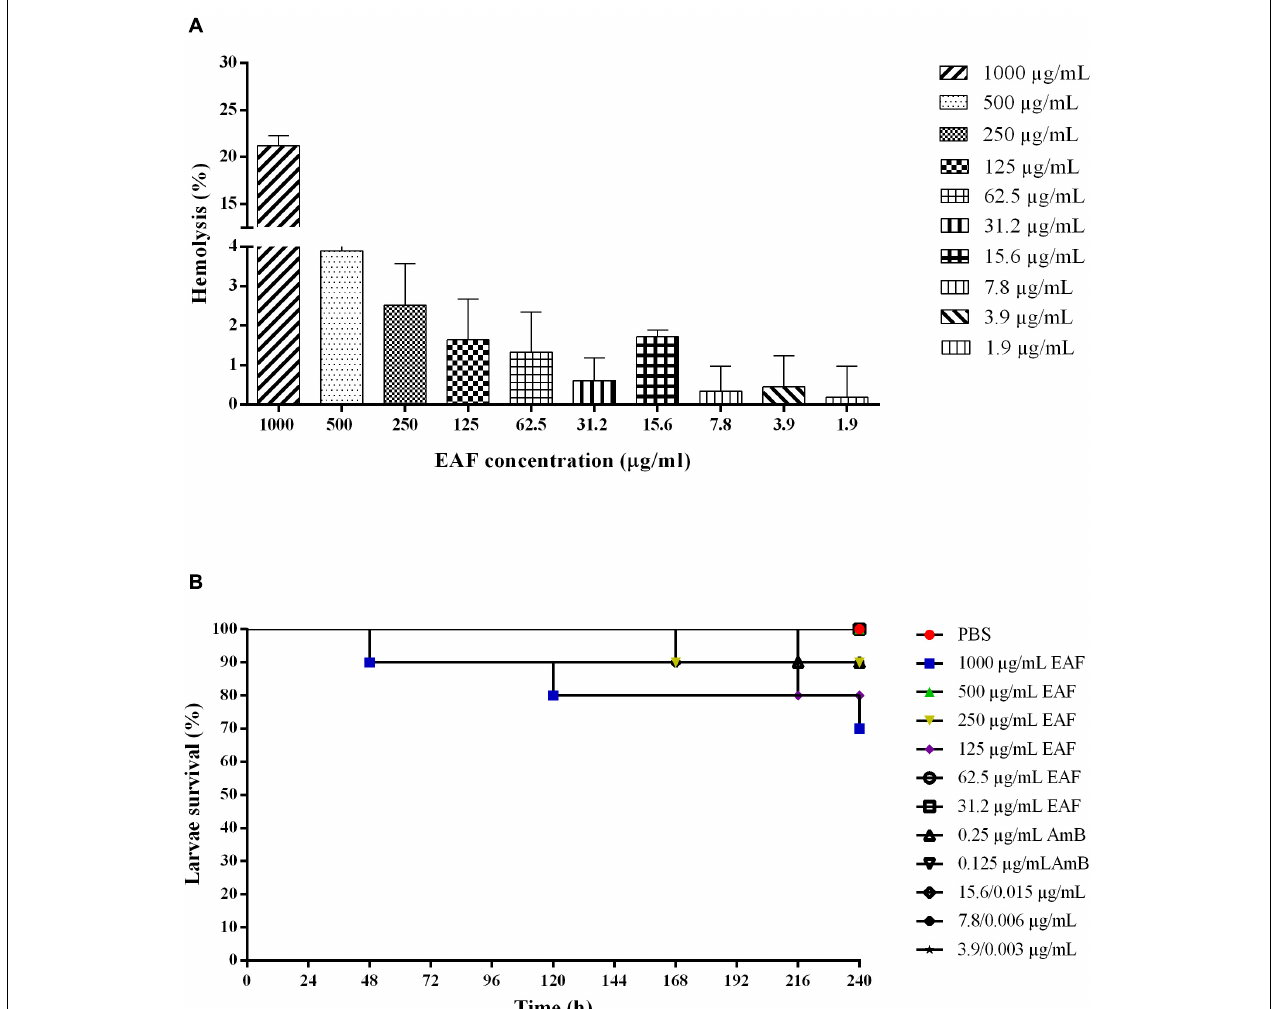
FIGURE 6 | Effect of ethyl acetate fraction (EAF) of Poincianella pluviosa bark and amphotericin B (AmB) alone or in combination against human erythrocytes (A) and Galleria mellonella larvae (B) . (A) Erythrocytes were treated with different concentrations (1,000.0–1.9 µ g/ml) of EAF during 3 h at 37 ◦ C. The percentage hemolysis was calculated using untreated cells as control. Values are mean ± standard deviation of two experiments in duplicate. (B) Kaplan–Meier plots of survival curves of G. mellonella larvae treated with different concentrations of EAF (1,000.0–31.2 µ g/kg of larvae), AmB (0.25 or 0.125 µ g/kg of larvae), and EAF combined with AmB (15.6/0.015, 7.8/0.006, or 3.9/0.003 µ g/kg of larvae) at the synergistic concentrations. Analysis of G. mellonella survival data was performed using the log-rank (Mantel–Cox) of representative experiment. PBS, phosphate-buffered